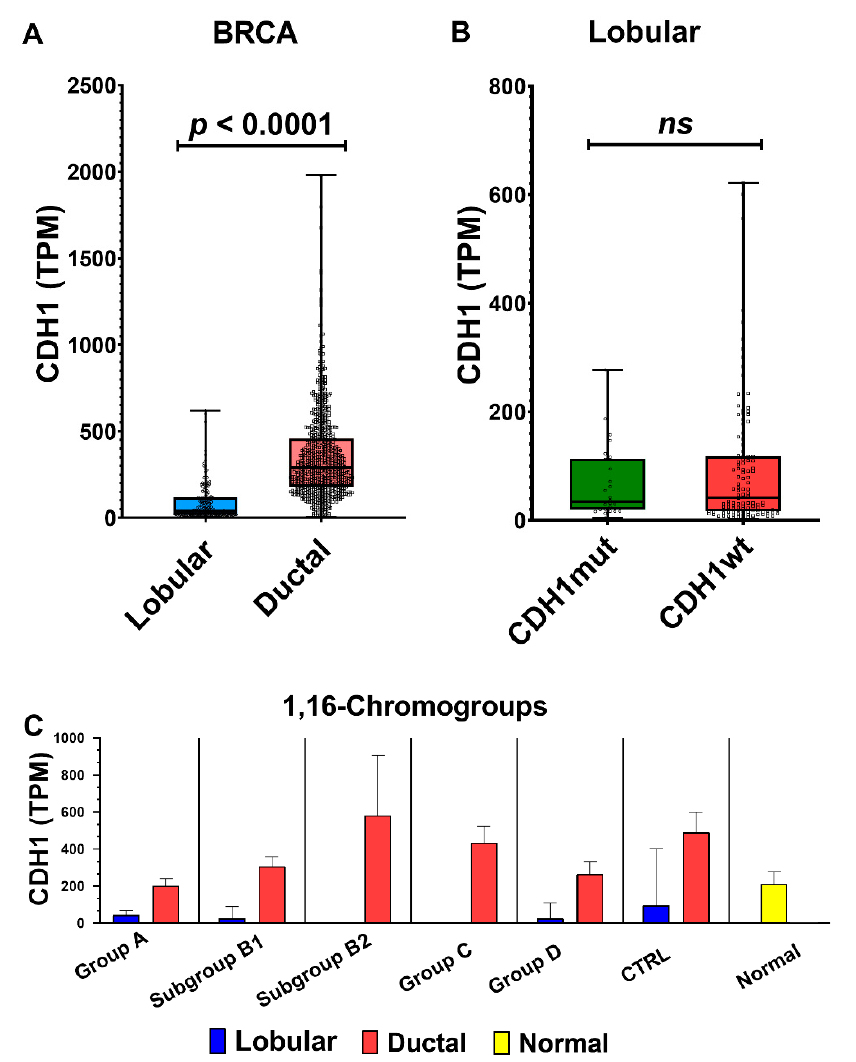
Figure 13. ( A ) Dot plots of CDH1 transcript levels in lobular and ductal carcinomas and ( B ) in lobular cancer bearing a mutated CDH1 (CDH1mut) or a wild-type CDH1 (CDH1wt); overlaid boxes show median and interquartile range; statistical significance by Mann–Whitney test; ( C ) TPM levels of CDH1 in different 1,16-chromogroups differentiated in lobular and ductal cancers. Columns represent the median values, and bars represent the 95% confidence intervals. ns: not statistically significant.